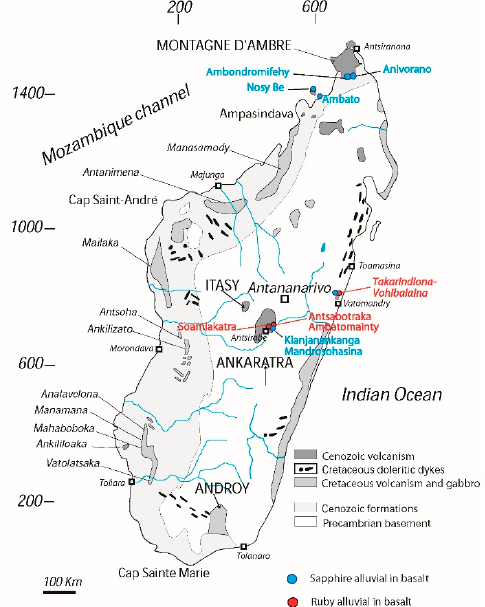
Figure 51. The volcanic provinces of Madagascar, modified from [256] with the localities of the basaltic corundum deposits related to the Cenozoic basalts in the provinces of Antsiranana, Antananarivo, and Toamasina [161,162]. The deposits of gem corundum: north in Antsiranana Province, the mining districts of Ambondromifehy and Anivorano in the Montagne d’Ambre, Ambato peninsula and Befotaka in Nosy Be island; Central Madagascar in Antananarivo Province, the mines of Soamiakatra, Mandrosohasina–Kianjanakanga (Antsirabe area) in the volcanic Ankaratra massif; and east in Toamasina Province, with the deposits of Vatomandry in the Takarindiona and Vohibalaina basaltic areas. The geographic coordinates are related to the Laborde projection.